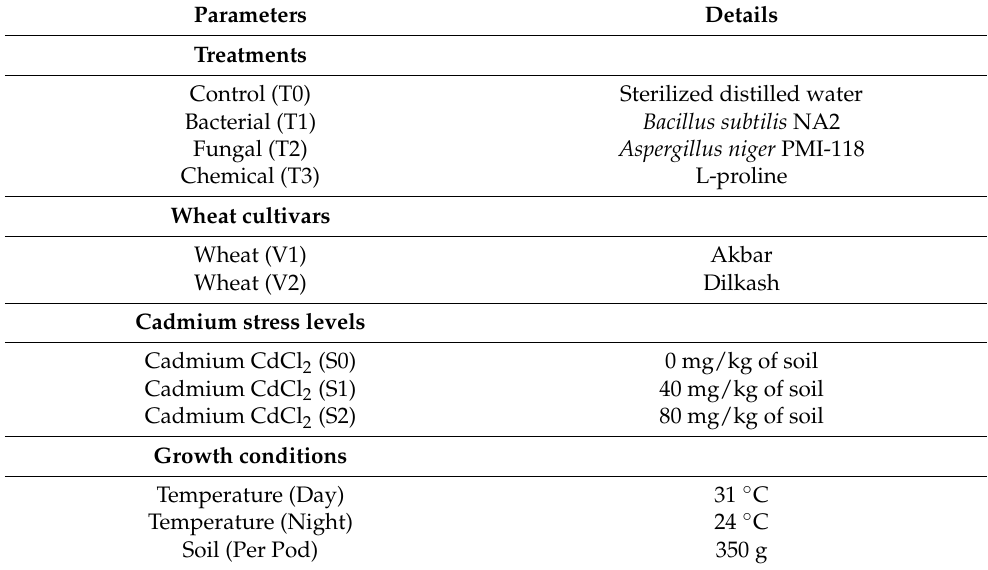
Table 1. Greenhouse experimental conditions for wheat ( Triticum aestivum L.) plants inoculated with Bacillus subtilis , Aspergillus niger and L proline under control and cadmium stress. Parameters Details Treatments Control (T0) Sterilized distilled water Bacterial